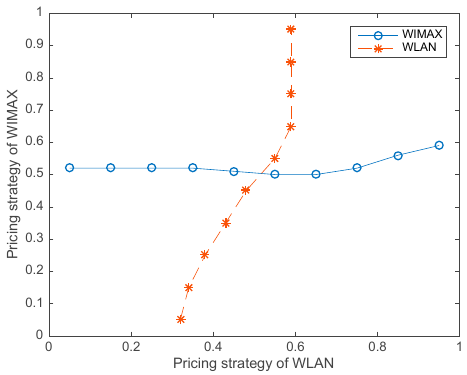
Figure 10. Nash equilibrium in the leader game.